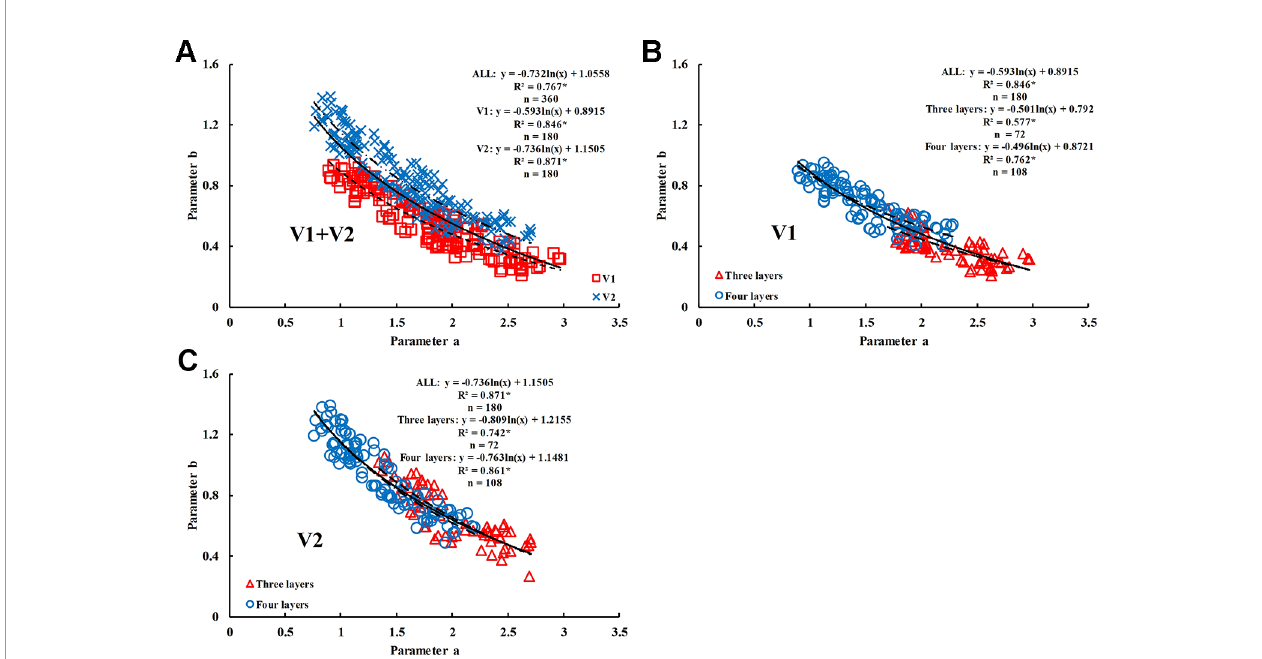
FIGURE 9 | Relationship between parameter ‘ a' and ‘ b' in different rice varieties. (A) V1+V2, (B) V1, and (C) V2. * means accurate to 0.001.